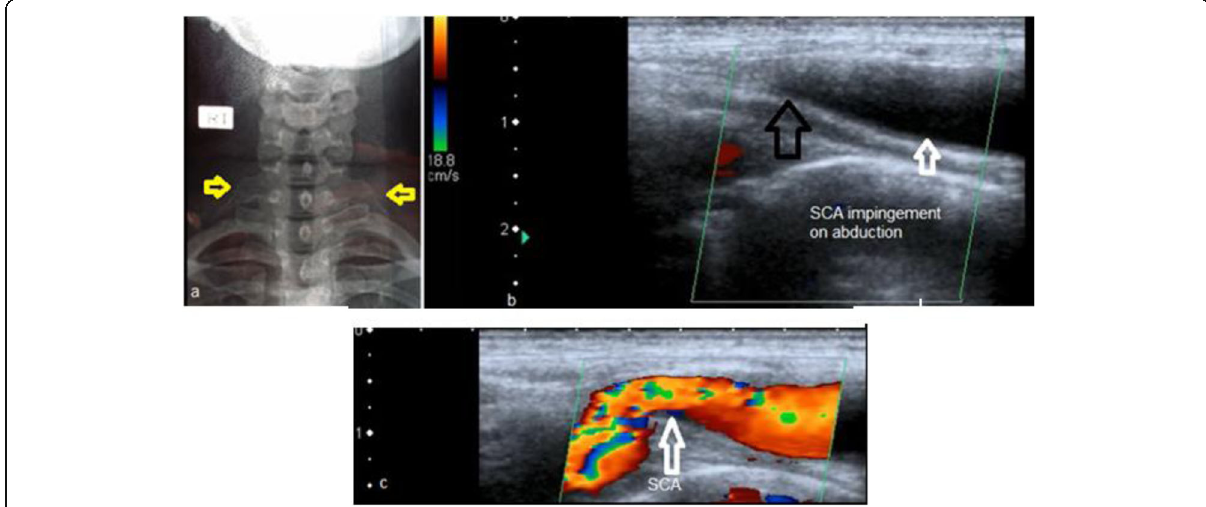
Fig. 2 a Plain X-ray image (AP view) showing bilateral cervical ribs (transverse yellow arrows). b Color Doppler image showing the left subclavian artery being impinged by 180° of arm abduction with no detectable flow in the distal segment (open white arrow) and severe narrowing “ peak configuration ” of the compressed segment (open black arrow). c Color Doppler image for the same artery but with 120° of arm abduction showing less significant stenosis of the artery denoted by the color aliasing (open white arrow) with filling of the distal